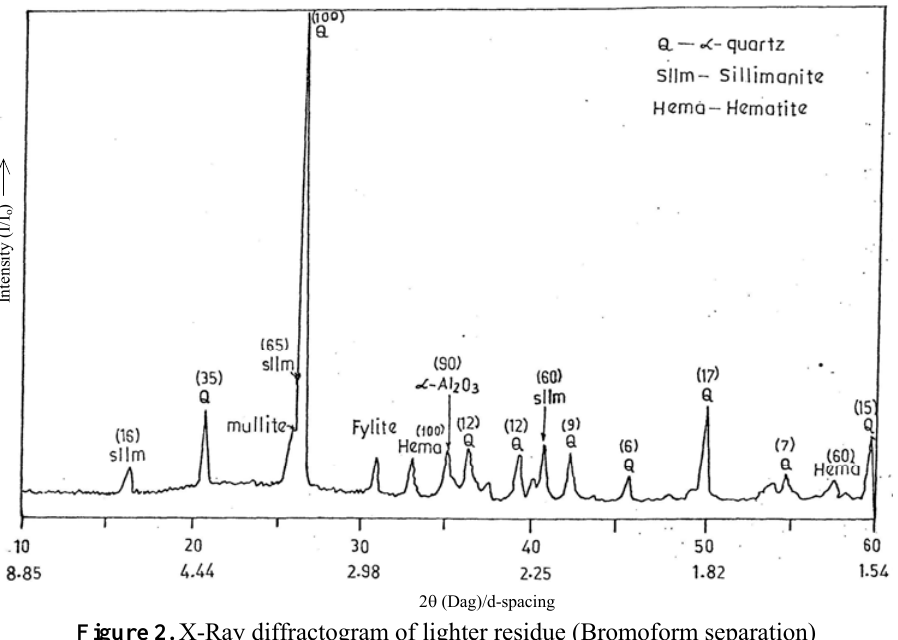
Figure 2. X-Ray diffractogram of lighter residue (Bromoform separation)